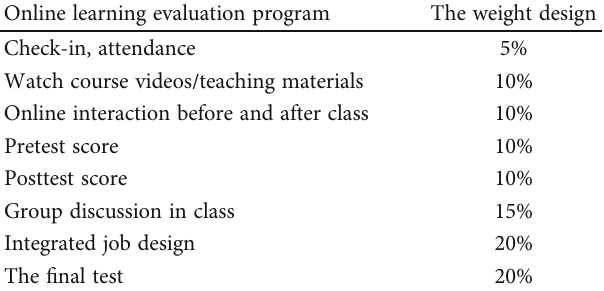
Table 4: Design of online learning e ff ect evaluation system. Online learning evaluation